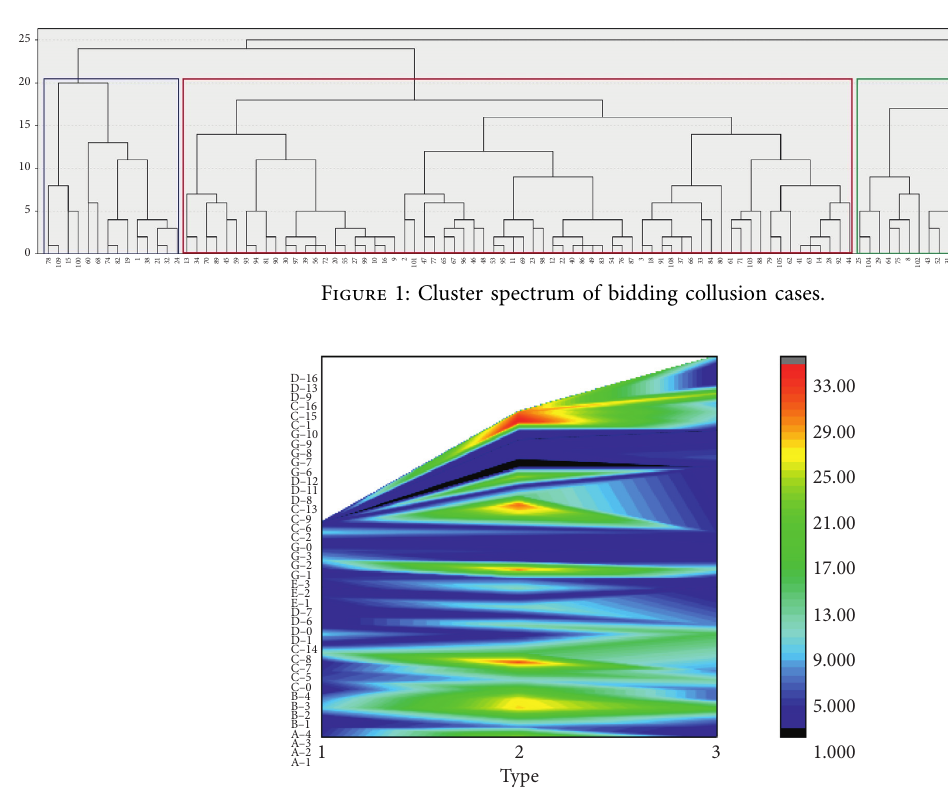
Figure 2: Statistical heat map of cases under each variable